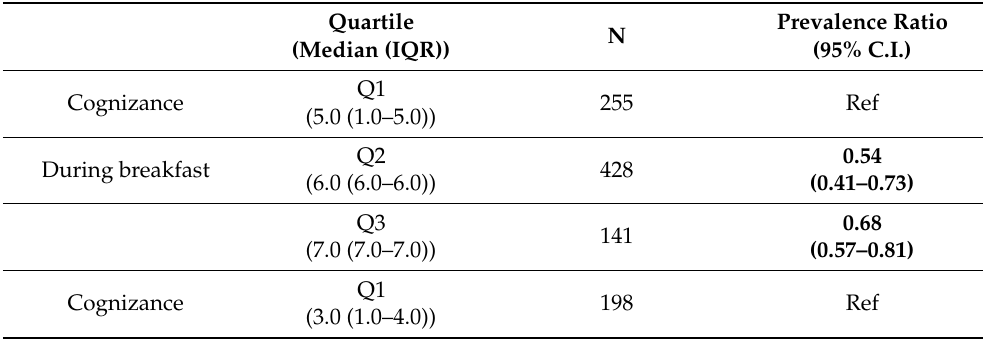
Table A1. Association between cognizance and self-efficacy and outcomes of Pro55+, stratified per meal moment. PRs and CIs in bold are